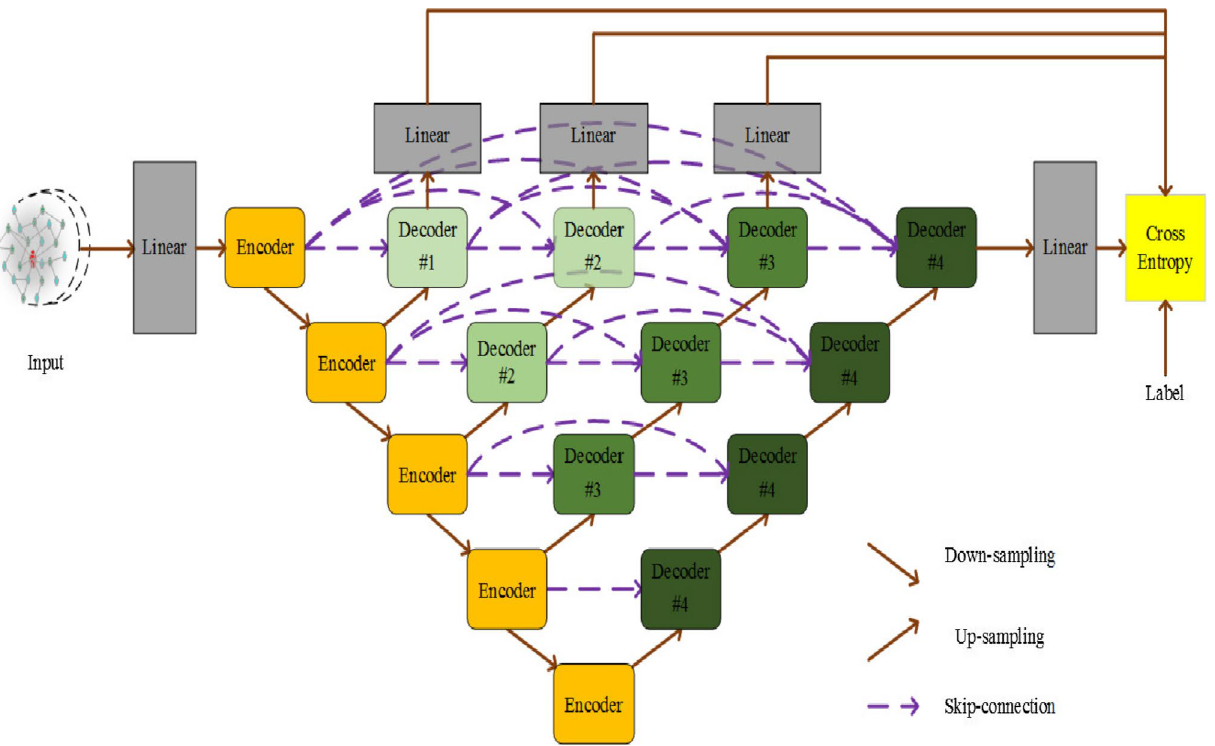
Fig. 4 The graph U-Net+